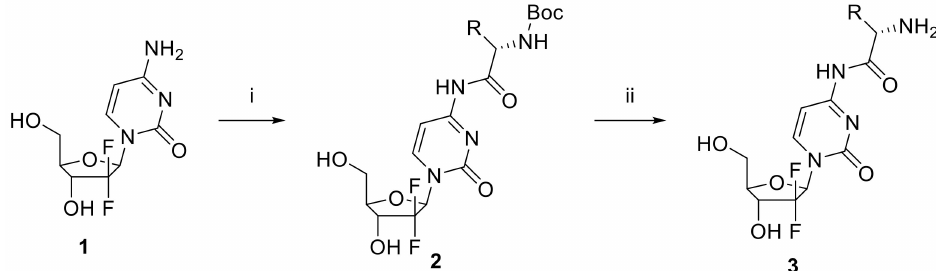
Figure 1. Synthetic scheme of the procedure used to synthesize gemcitabine-amino acid prodrugs. Reagent and conditions were as follows; (i) N -Boc- L -amino acid, 4-methylmorpholine, HOBt, EDCI · HCl, DMF/DMSO = 3: 1, 55 ◦ C, 17 h; (ii) 4N HCl in dioxane, dry CH 2 Cl 2 , r.t. 30 min.